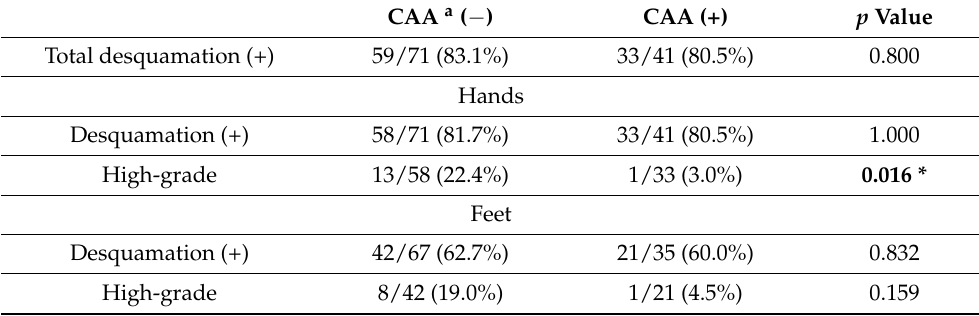
Table 4. CAA formation incidence in